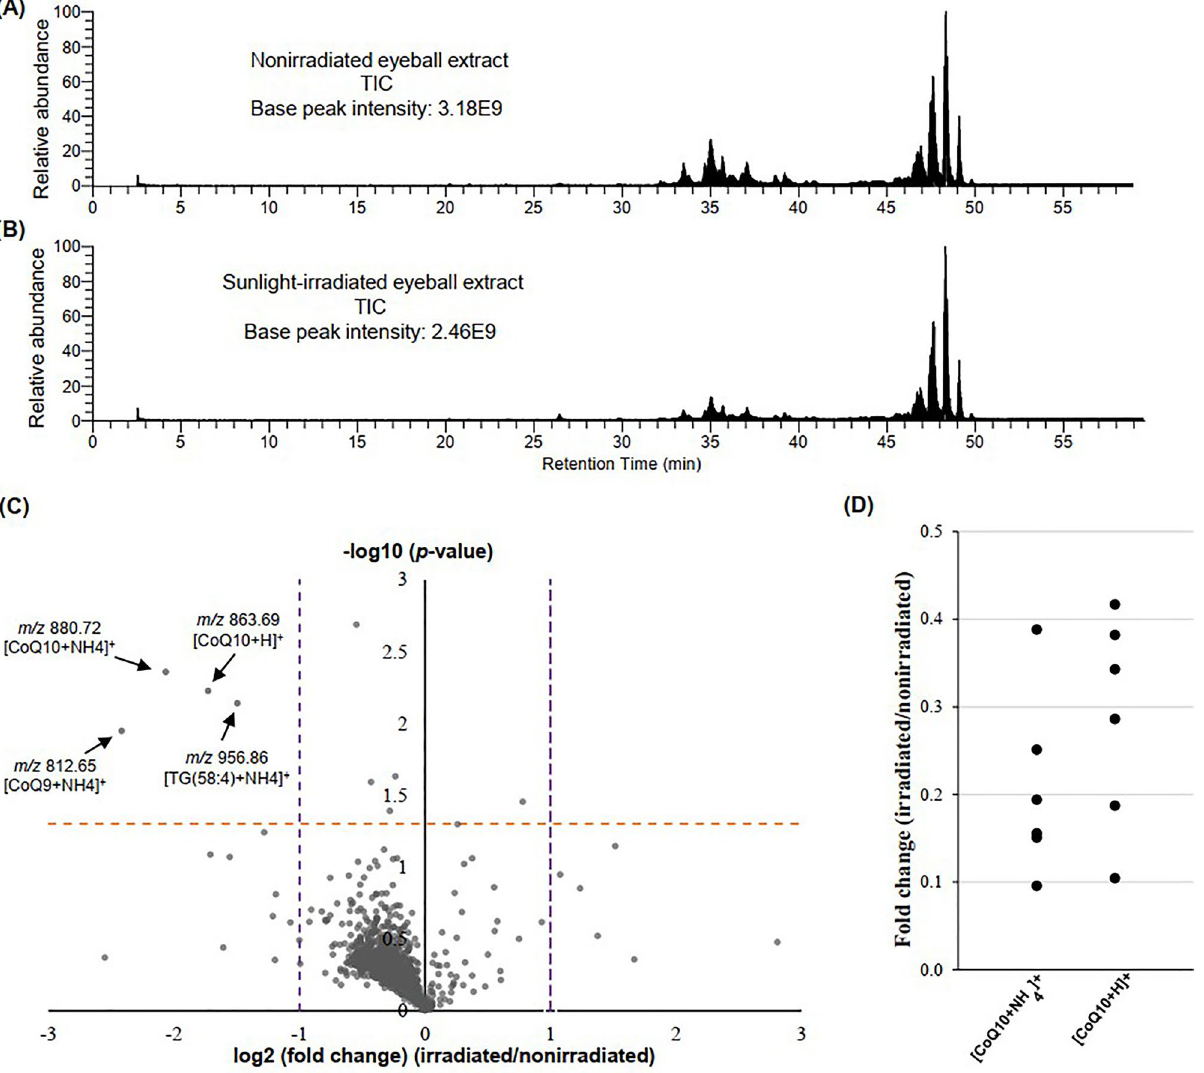
Figure 1. Exploration of potential isomerizable lipids in eyeballs upon sunlight irradiation. Total ion chromatogram (TIC) was obtained from the ( A ) nonirradiated and ( B ) irradiated eyeball extract (data of the first paired sample was shown here). Both positive and negative ion mode data were shown in the TIC. ( C ) Volcano plots of 1001 identified lipid species in the eyeball extracts. The dashed orange line show where p = 0.05. The dashed purple lines at the right and left show where fold change (irradiated/nonirradiated) = 2 and 0.5, respectively. The ions-of-interest that showed both large magnitude fold changes (x-axis) and high statistical significance (y-axis) were annotated. ( D ) Distributions of fold changes (irradiated/nonirradiated) of ions associated with CoQ10. A single dot in the dot plot indicates the fold change of one paired sample. The average retention time for [M + H] + and [M + NH 4 ] + of CoQ10 shown here was 45.69 min and 45.70 min, respectively. CoQ10 Coenzyme Q10, CoQ9 Coenzyme Q9, TG ( 58:4 )